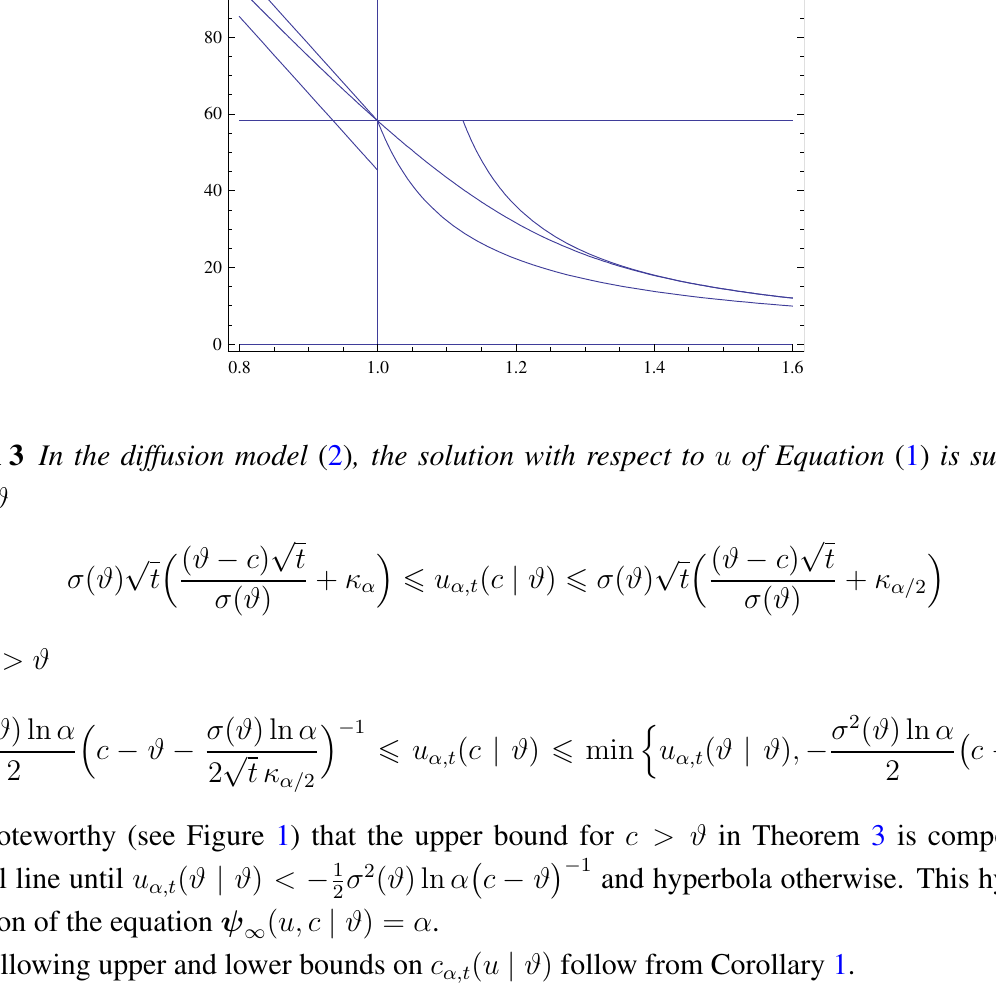
√ t κ ( ϑ | ϑ ) = σ ( ϑ ) . α,t α/ 2